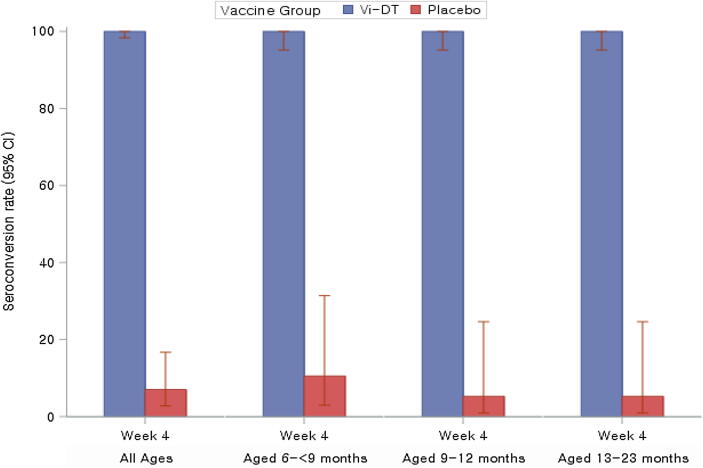
Seroconversion rates as measured by anti-Vi IgG ELISA Response. [Note] Seroconversion rate is proportion of participants who had 4-fold rise in titers compared to baseline (Day 0, Week 0) to post dose. Among all participants the difference in seroconversions post single dose compared to the placebo group was statistically significant (P < 0.0001).